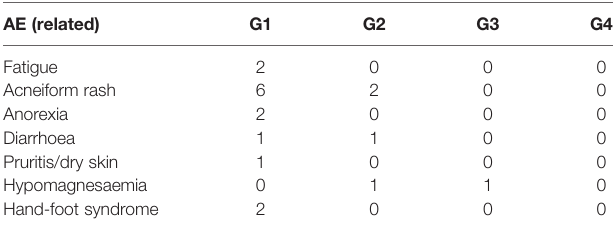
TABLE 3 | All treatment related adverse events in 8 patients, according to NCI- CTCAE V4.0 criteria. AE (related) G1 G2 G3